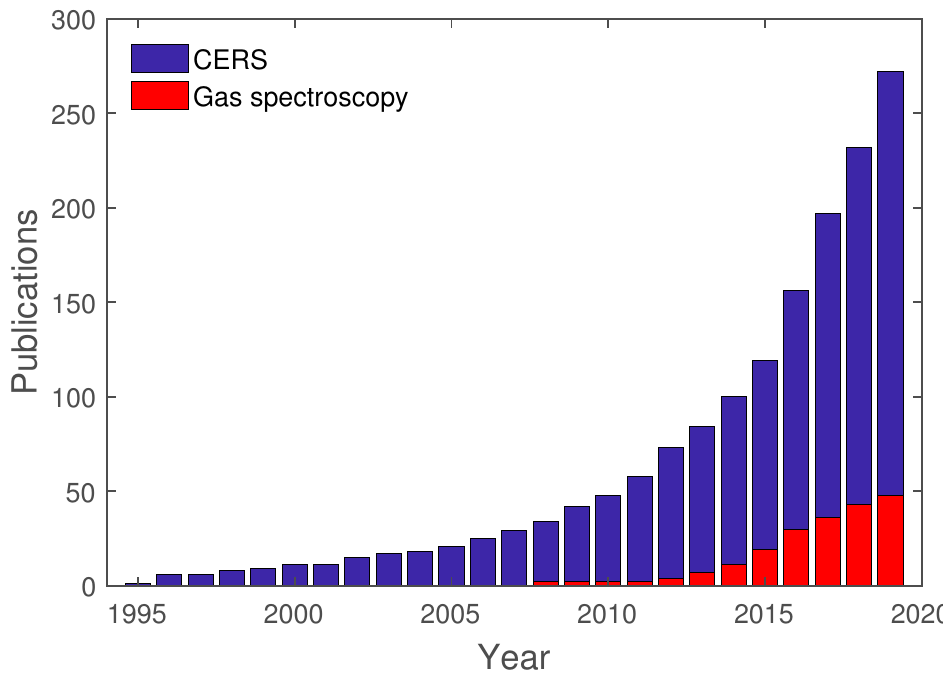
Figure 7. Publications regarding CERS, in general, and cavity-enhanced Raman gas spectroscopy, in particular.